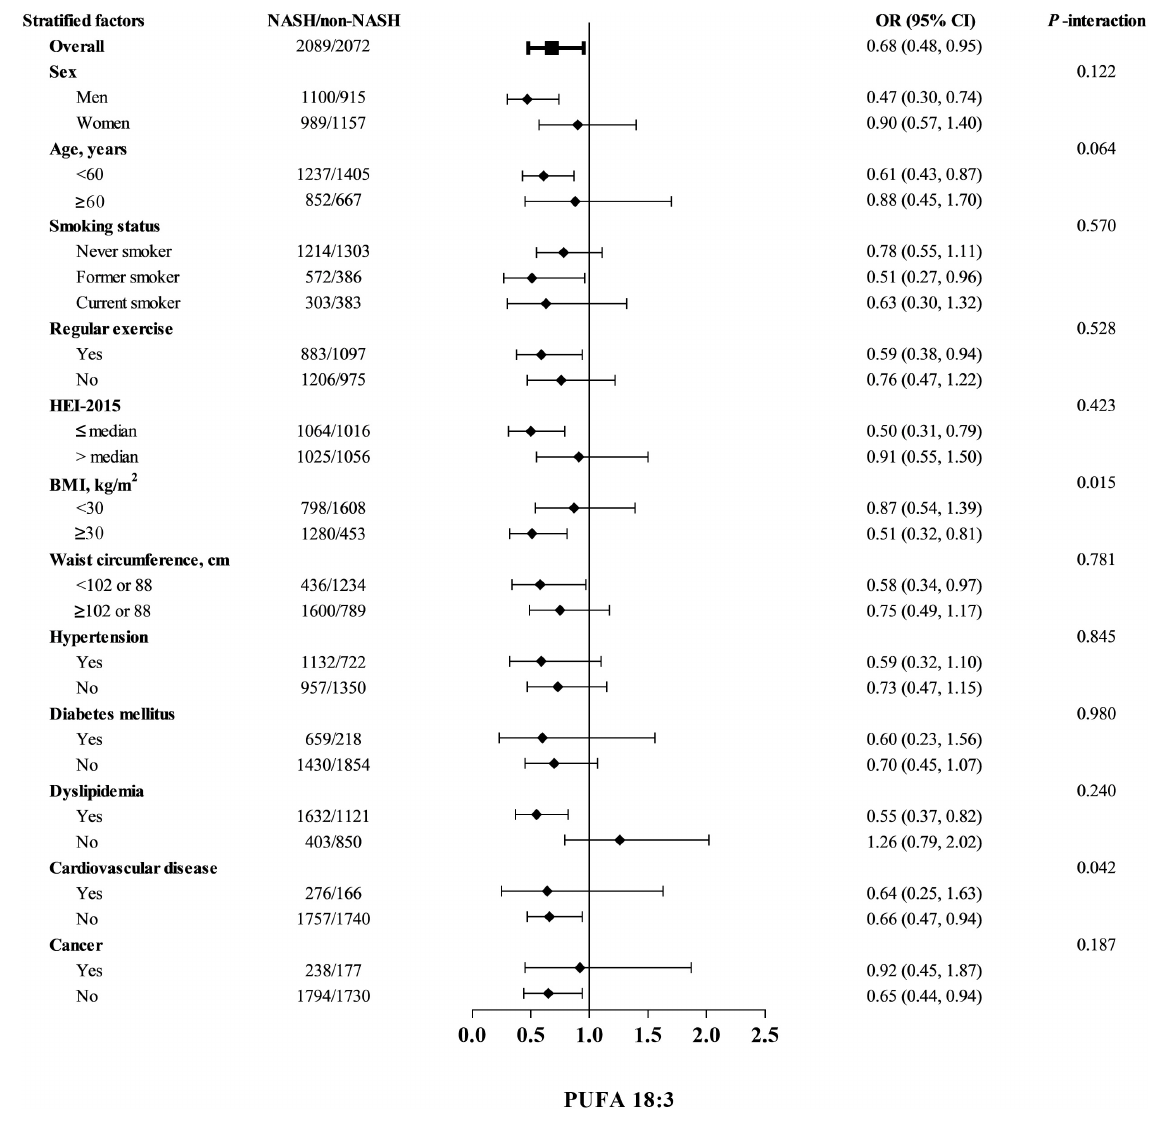
FIGURE2 Odds ratios (ORs) and 95% confidence intervals (CIs) of non-alcoholic steatohepatitis by terciles of dietary PUFA 18:3 among controls stratified by covariates. Abbreviations: PUFA, polyunsaturated fatty acid NASH, non-alcoholic steatohepatitis; HEI-2015, healthy eating index-2015; and BMI, body mass index. Cut-off points of waist circumference were 102 cm for men and 88 cm for women. Odds ratios were adjusted for age, sex, BMI, ethnicity, marital status, education levels, family income-to-poverty ratio, waist circumference, smoking status, regular activities, use of oral corticosteroid, energy intakes, HEI-2015, ALT, ALP, AST, GGT, hypertension, diabetes mellitus, dyslipidemia, cardiovascular disease, and cancer. Stratified factors were not included in the corresponding